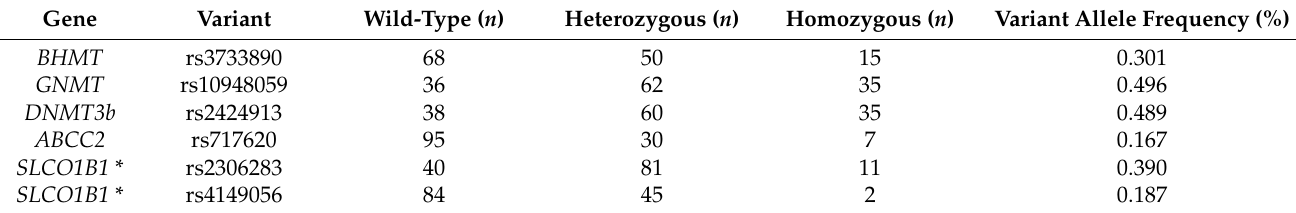
* Haplotypes based on the genotype combinations for both polymorphisms, classified according to activity: high-activity haplotypes SLCO1B1*1a , n = 30 and SLCO1B1*1b , n = 54; low-activity haplotypes SLCO1B1*5 , n = 10 and SLCO1B1*15 , n = 37. ABCC2, ATP-binding cassette transporter C2 ; BHMT , betaine-homocysteine methyltransferase ; DNMT3b , DNA (cytosine-5-)-methyltransferase 3 β ; GNMT , glycine N-methyltransferase ; SLCO1B1 , solute carrier organic anion transporter family member